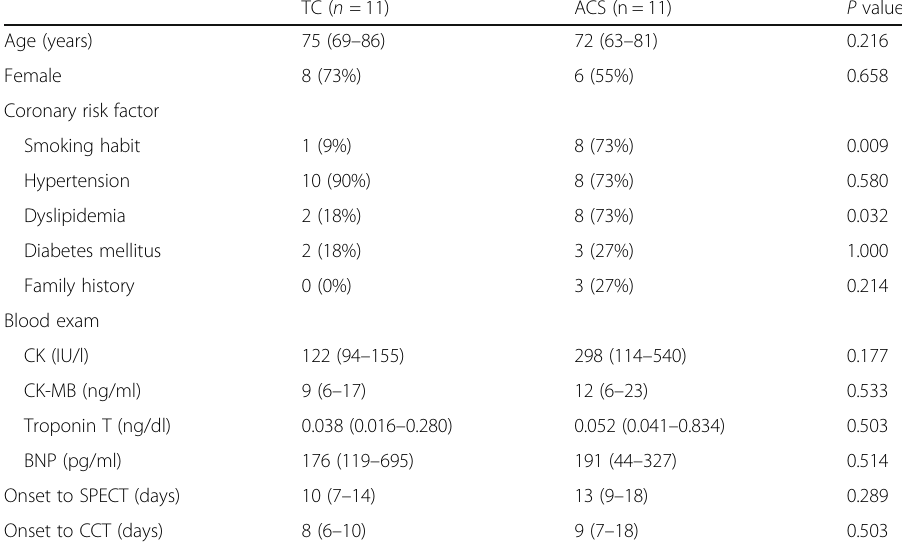
Table 2 Patient characteristics in TC and ACS